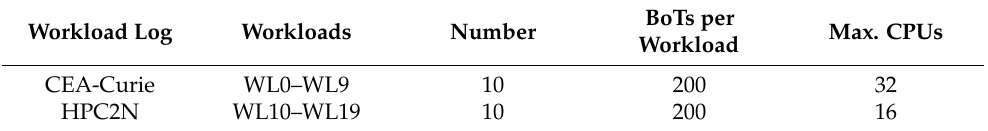
Table 5. Sample real experimental workloads.